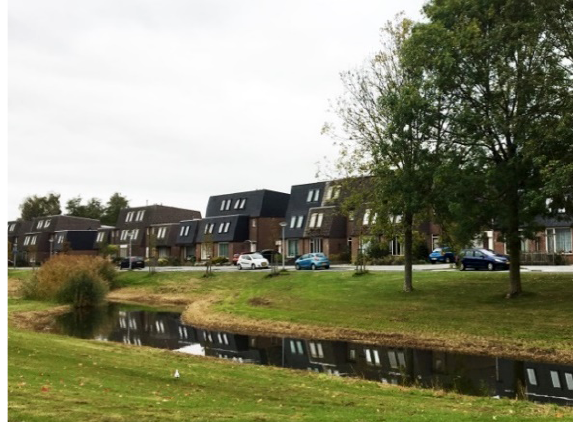
Figure 16. Tjalk: view of row houses. Source: authors.